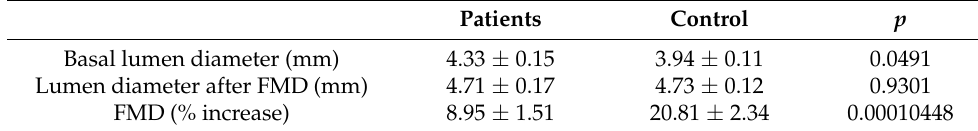
Table 3. Endothelial function features (mean ± SEM).